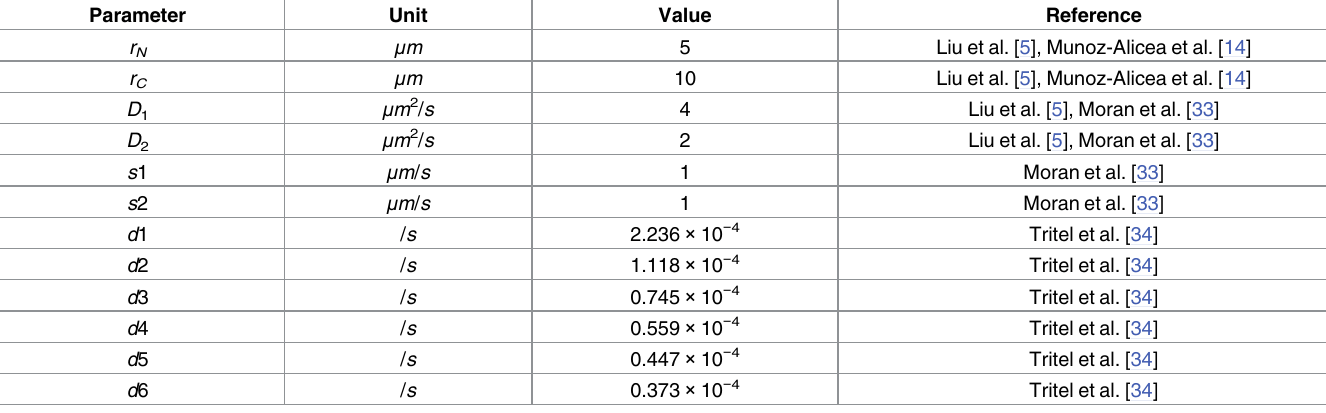
Table 3. Some parameter values estimated by the experimentally